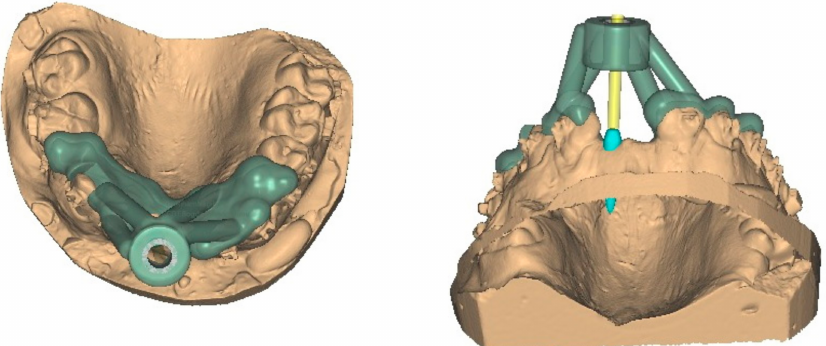
Figure 1. Individualized 3D printed surgical insertion guide for mini-implants in the maxillary frontal area. The blue component is the simulated TAD. The yellow component simulates the insertion tool (orthodontic mini-implant